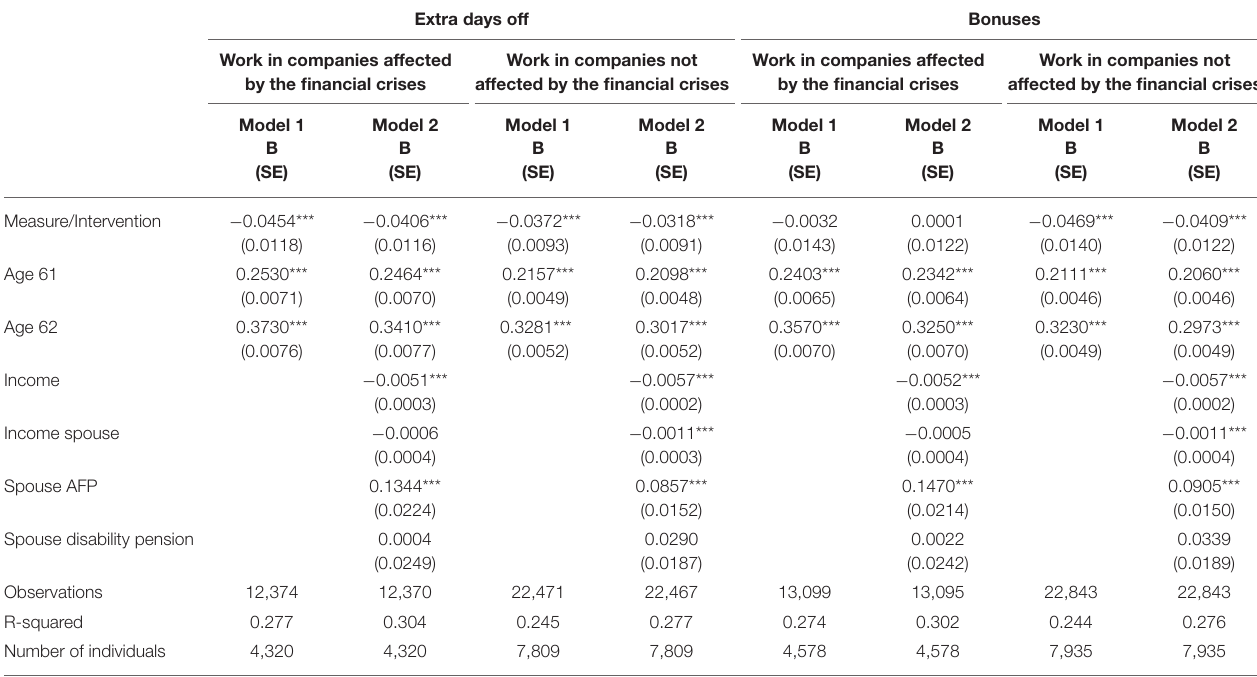
TABLE 3 | Individual probability of receiving an early retirement benefit among 62- and 63-year-olds, depending on the measure exposure (extra days off and bonuses), before and after controlling for a range of individual time-variant